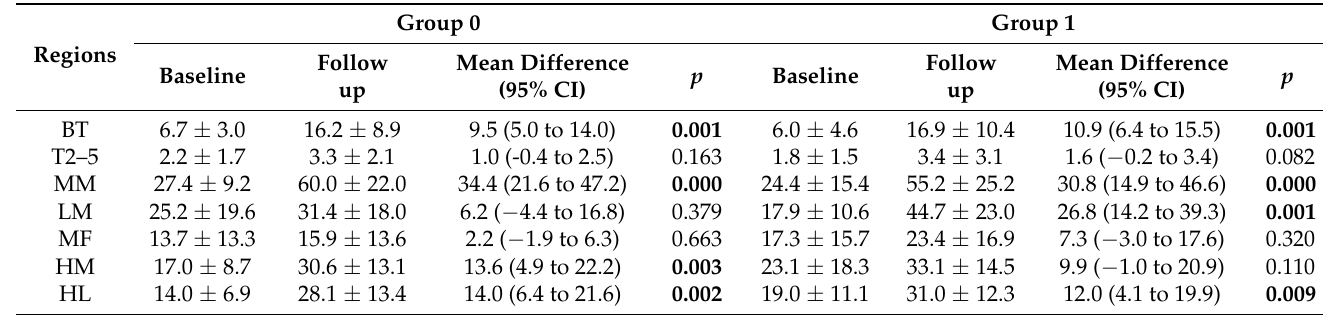
Table 3. FTI (N · s) and the difference values.